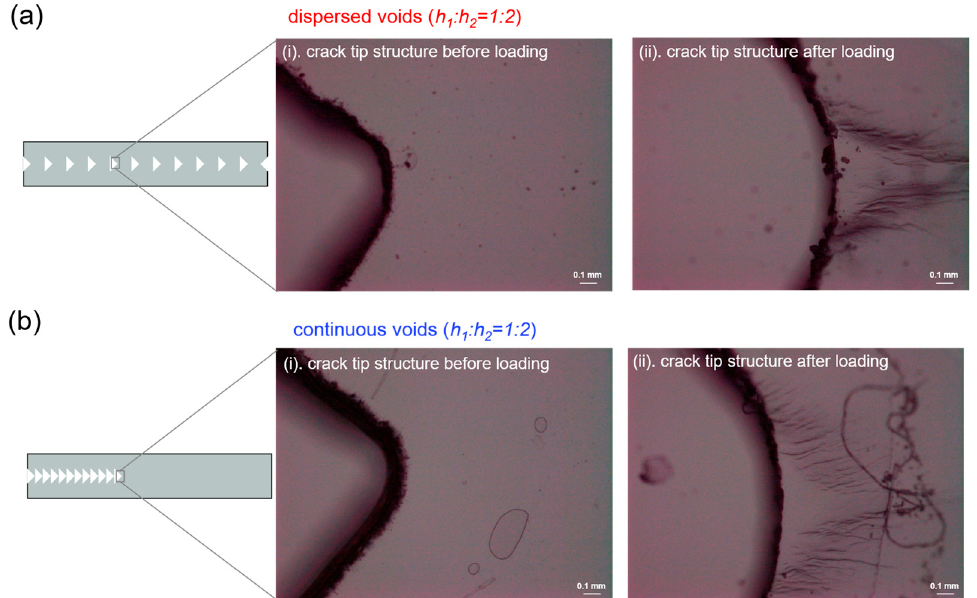
Figure 9. The crack tip structure of DN hydrogels was observed by optical microscopy. ( a , b ) The representative crack tip structure in DN hydrogel samples before and after loading to a stretch ratio λ of 2 under different structural models containing dispersed cuts ( a ) and continuous cuts ( b ) at spacing ratio h 1 : h 2 of 1:2. Wrinkles-like damaged structure can be observed ahead of the crack tip, corresponding to the damage zone observed by birefringence.